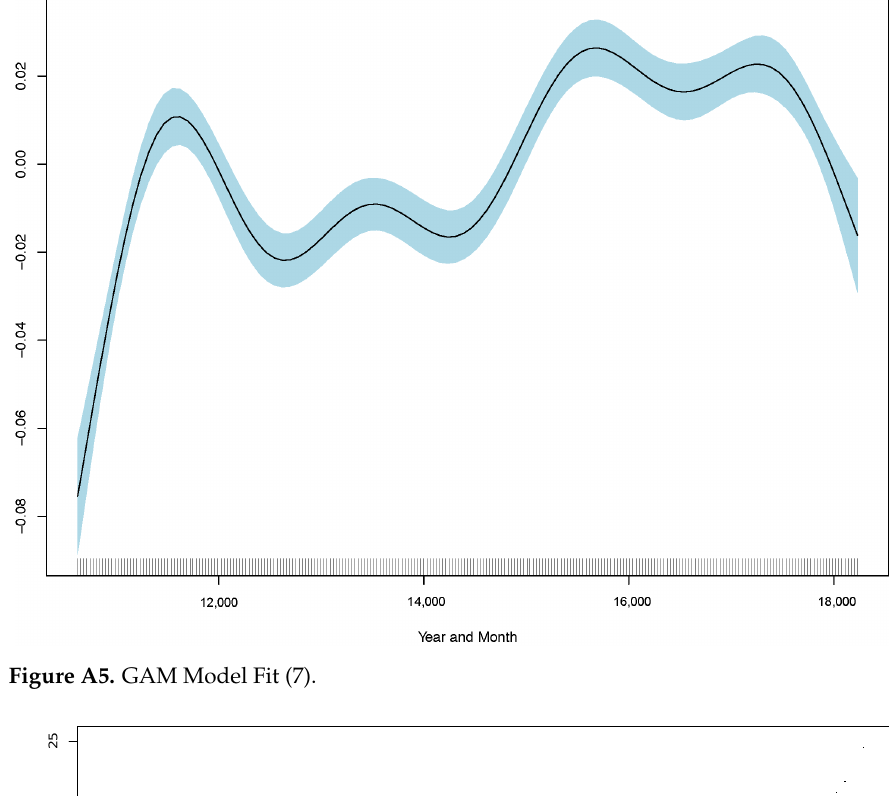
Figure A5. GAM Model Fit (7).